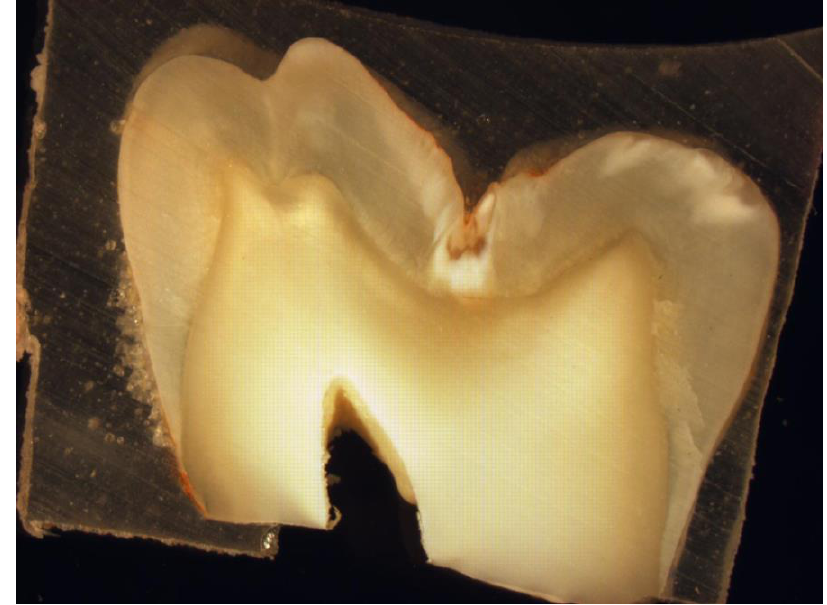
Figure 2. Histological section of a permanent molar.